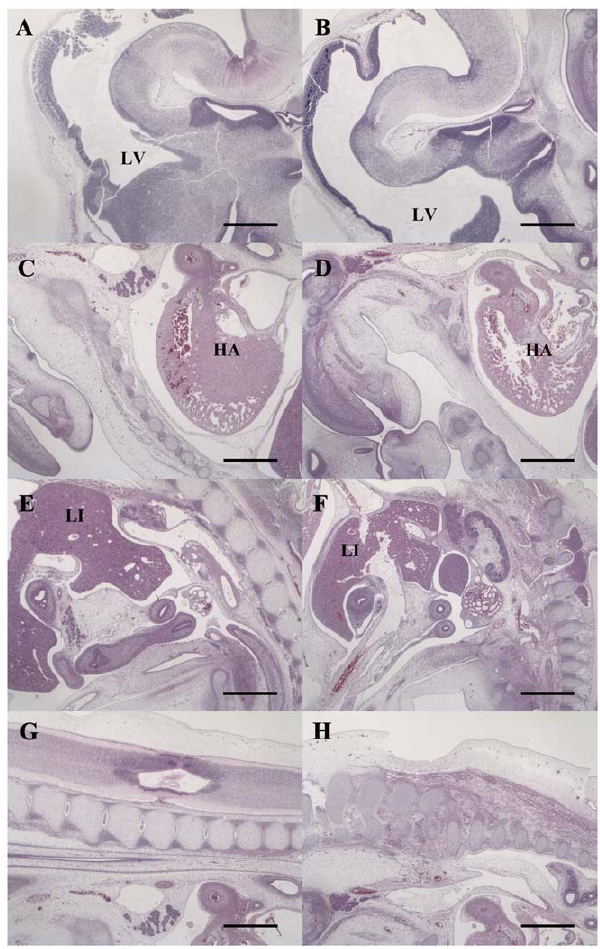
Figure 4. Histological analysis of day 30 control (A, C, E, G) and parthenogenetic (B, D, F, H) canine fetuses. H&E staining of head (A, B), heart (C, D), liver and intestine (E, F), and vertebral area (G, H) showed similar development of major organs in canine parthenotes and controls. Note also the artificially inseminated fetus on day 30 was slightly larger than the canine parthenote. All scale bars represent 1 mm. LV, lateral ventricle; HA, heart; LI, liver.